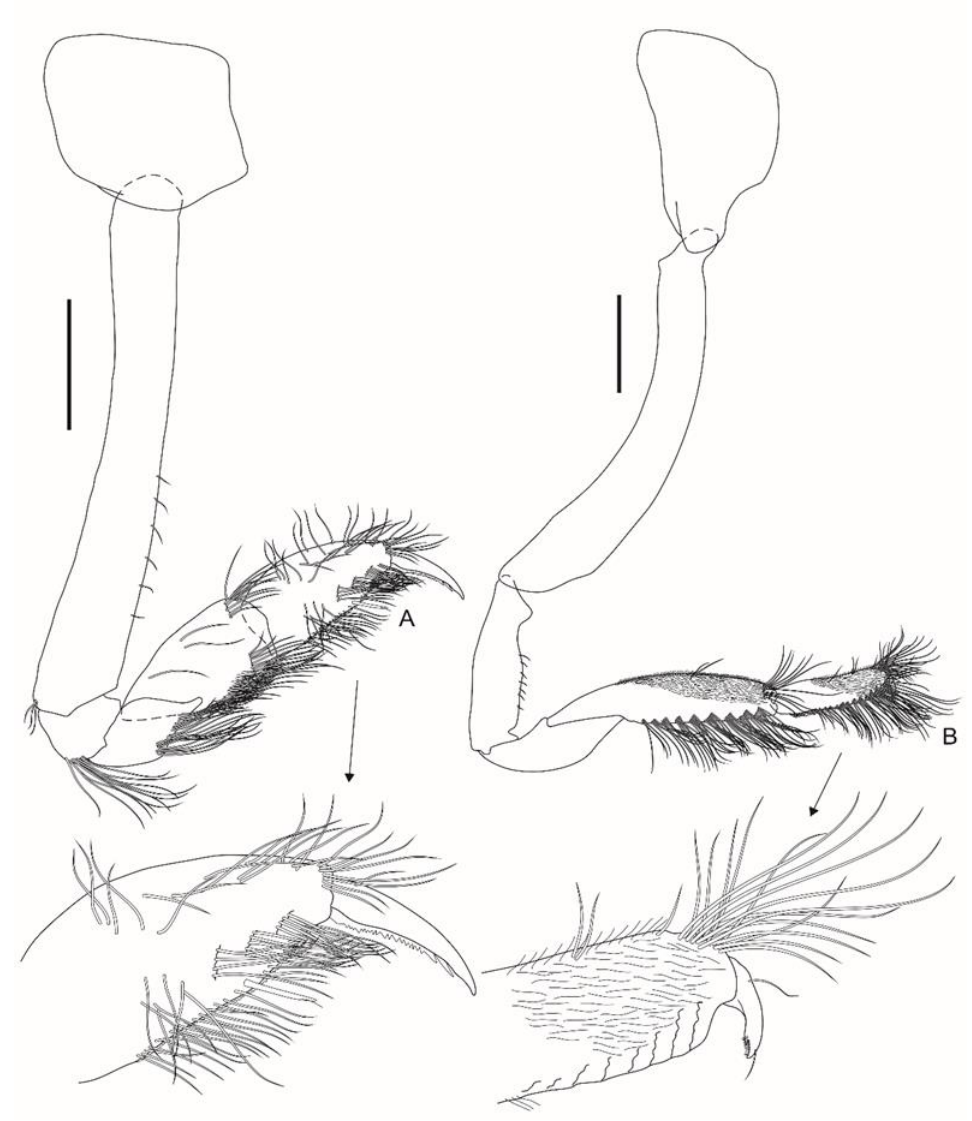
Figure 4. Cyphocaris boecki sp. nov., female holotype, 33.3 mm (MOUFPE 20068). ( A ) Gnathopod 1; ( B ) Gnathopod 2. Scale bars: 1 mm. ( B ) Gnathopod 2. Scale bars: 1